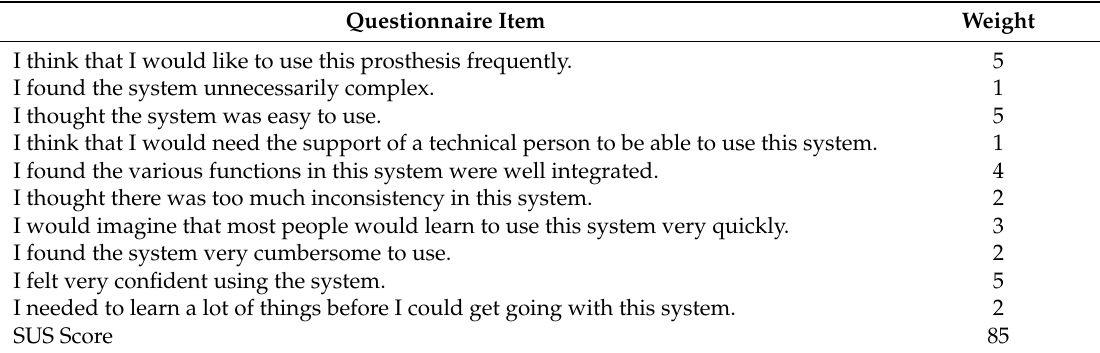
Table 5. System usability scale (SUS) score a